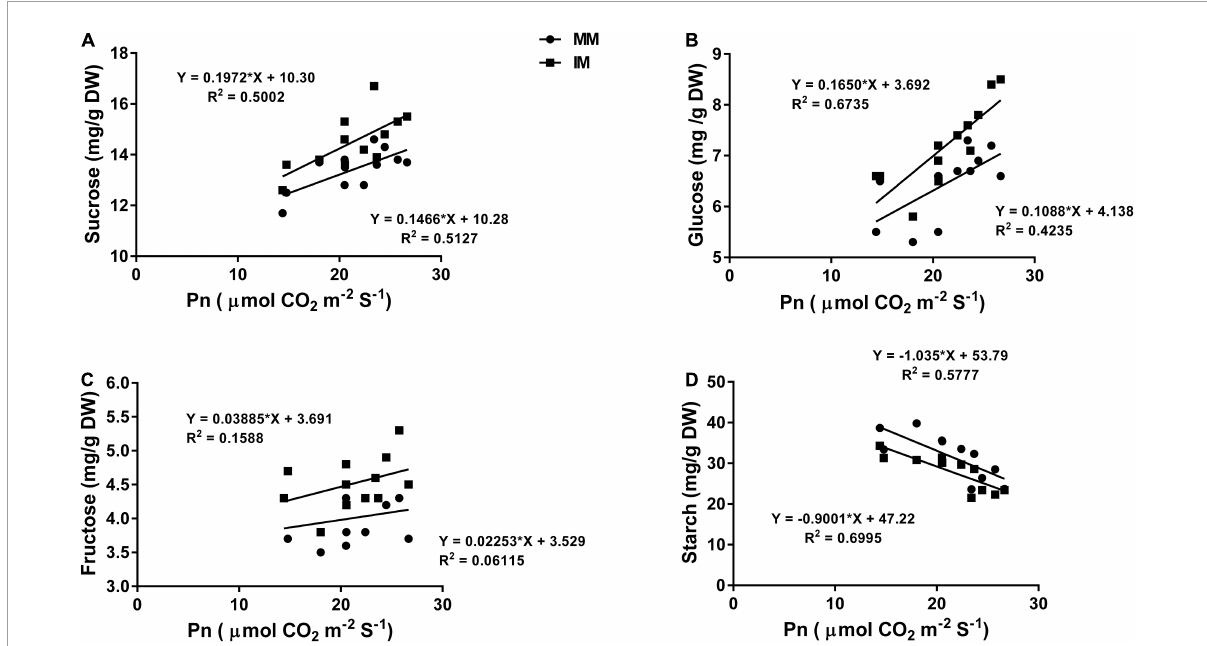
FIGURE7 Regression analysis of the photosynthetic rate with sucrose (A) , glucose (B) , fructose (C) , and starch (D) of maize leaf during mono-cropping and intercropping. MM, maize mono-cropping; IM, maize